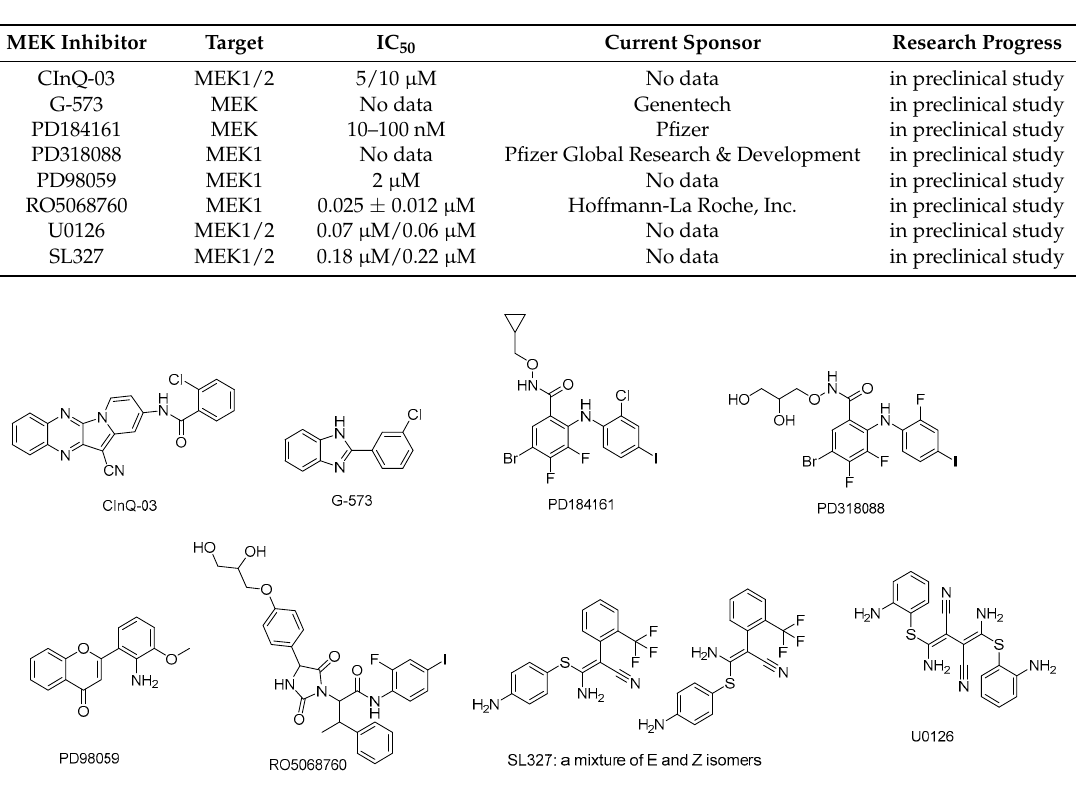
Table 3. MEK inhibitors in preclinical development